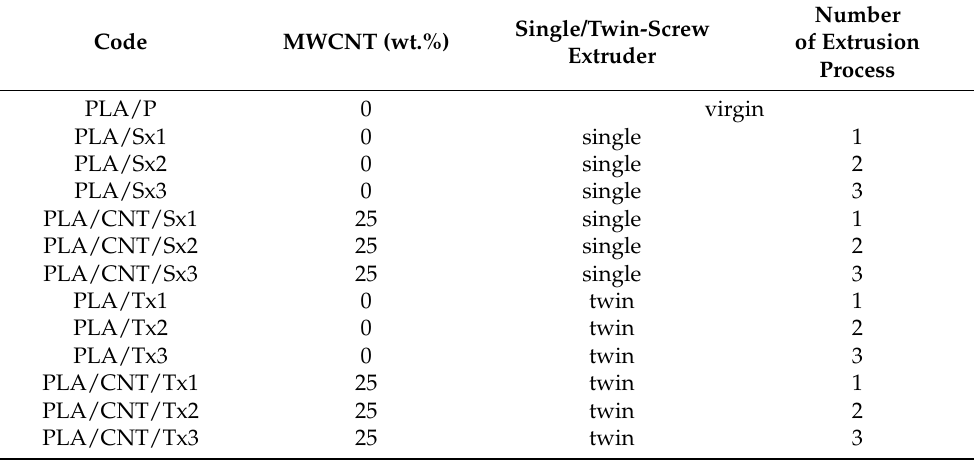
Table 1. List of abbreviations and formulations of the tested PLA/MWCNT